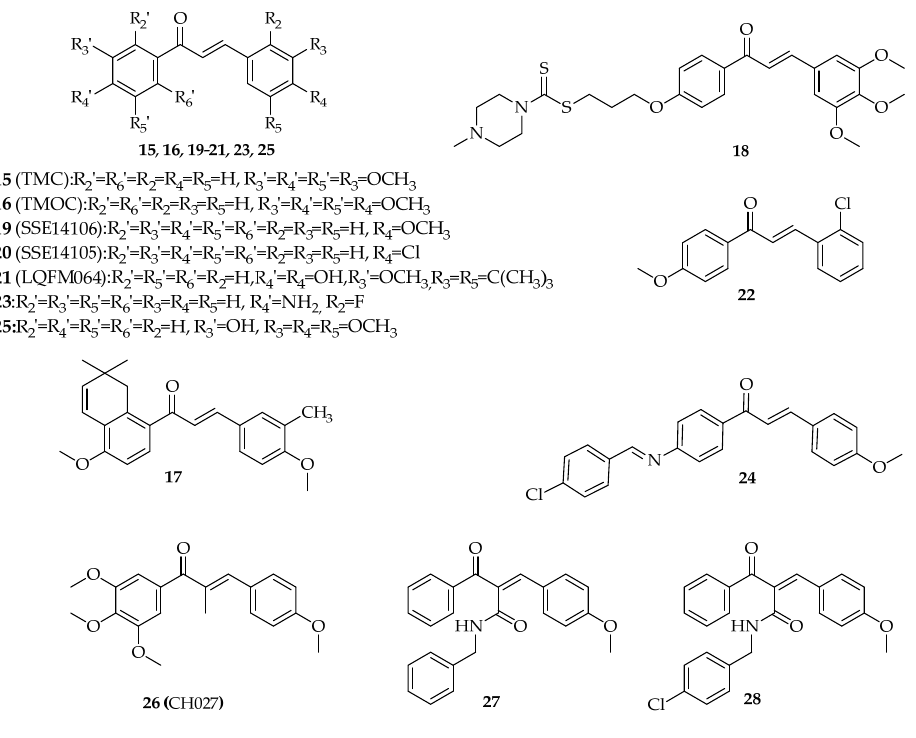
Figure 5. Structure of chalcones 15 – 28